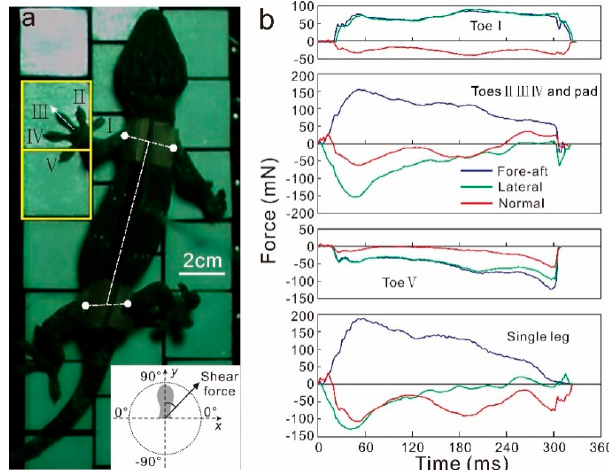
Figure 2. ( a ) Top view of the gecko running on the force measurement array (FMA). The front left limb is contact with three force sensors. ( b) Three-dimensional force-time curves of different toes in front left limbs.